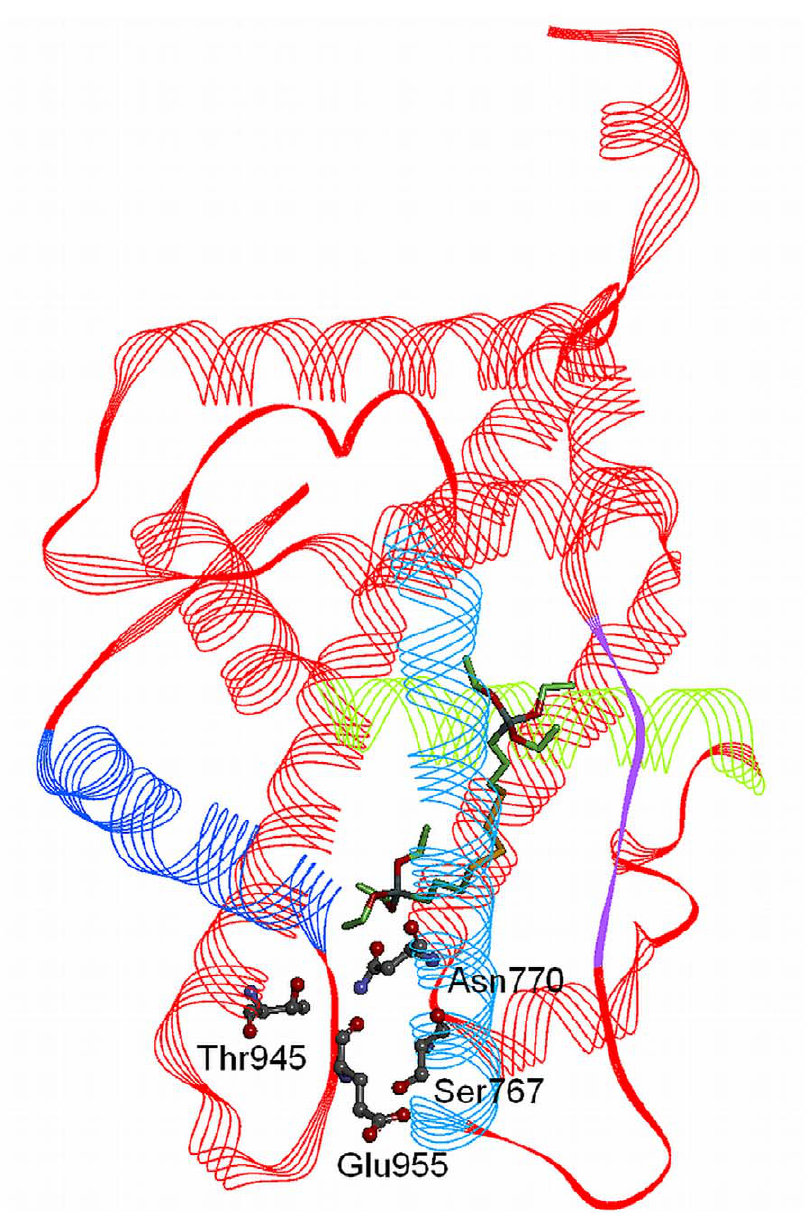
Figure 9. MR with silane AB110873. The amino acids that form the hydrogen bond network with steroidal agonists are highlighted in ball and stick style. AF-2 (helix 12) is colored in dark blue, helix 5 in green, helix 3 in light blue, and the b -sheet in lilac. The buried hydrophobic pocket additionally occupied by AB110873 is formed by amino acids from helices 3 (Val780) and 5 (Leu809, Ala813), and from the b -sheet (Val750).